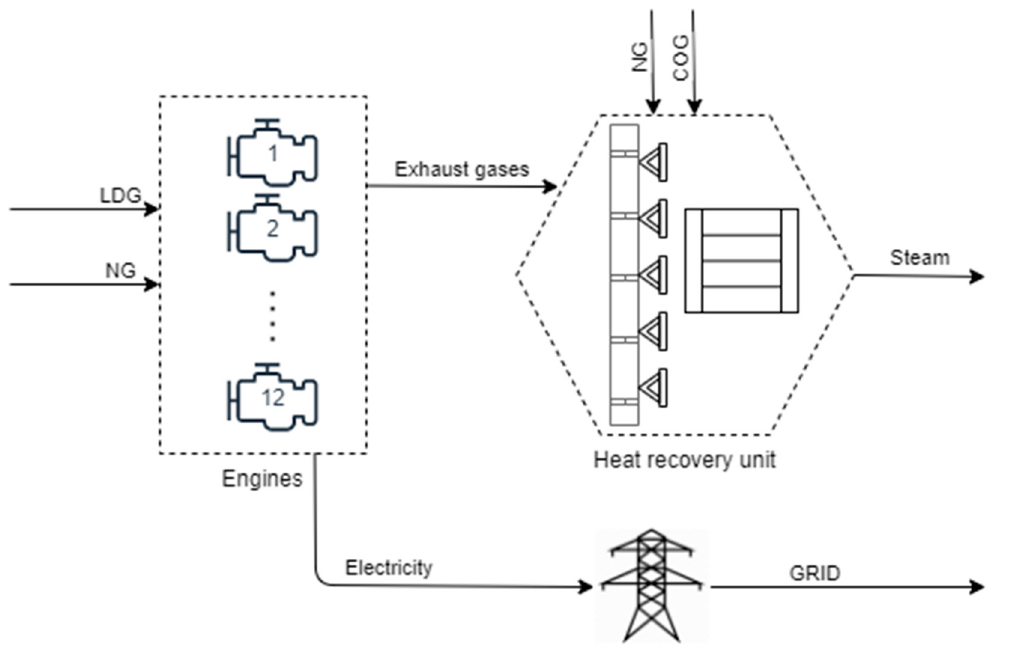
Figure 3. Schematic view of the electrical plant.